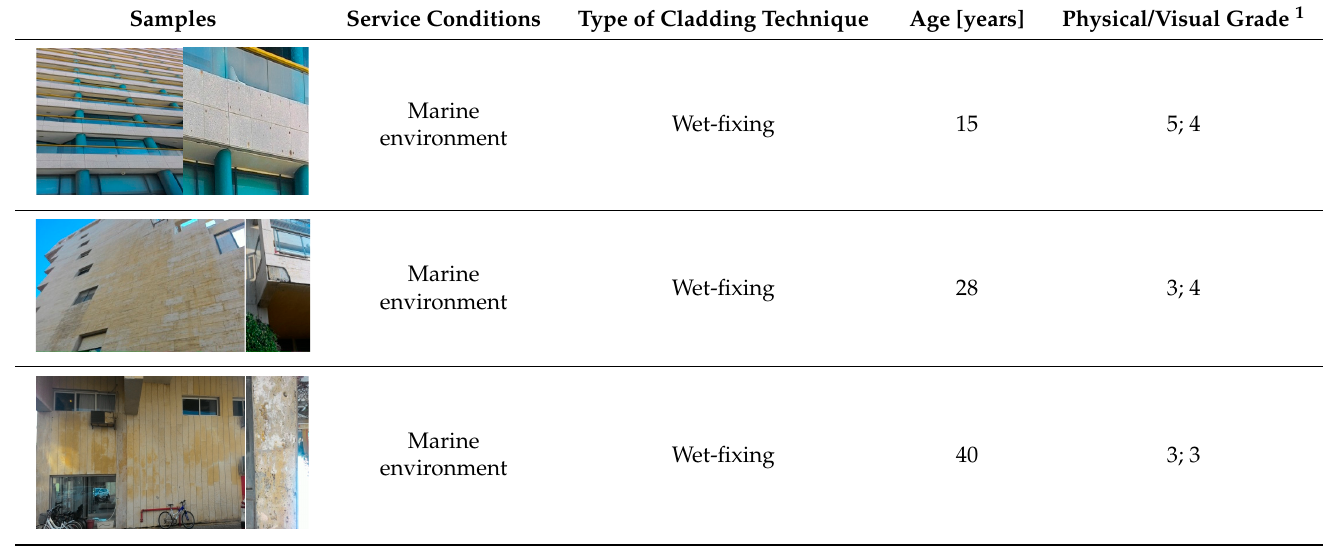
Table 5. Characteristics of three dry- fi xed stone claddings observed in marine environment.